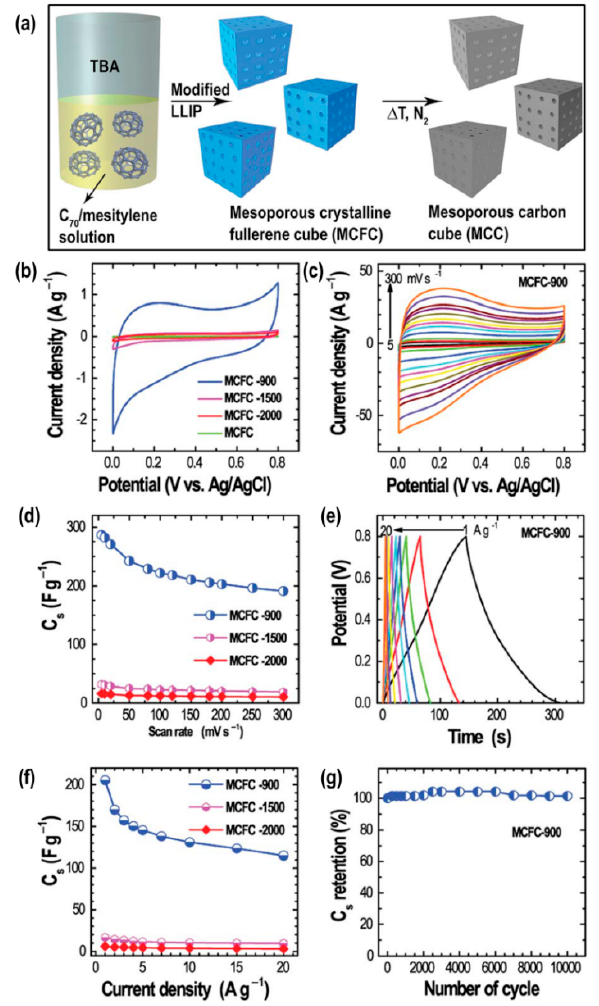
Figure 2. ( a ) Illustration of the synthesis of mesoporous crystalline fullerene cube (MCFC) and mesoporous carbon cubes. ( b ) Comparison of CV curves of carbon samples at 5 mV s − 1 , ( c ) CV curves